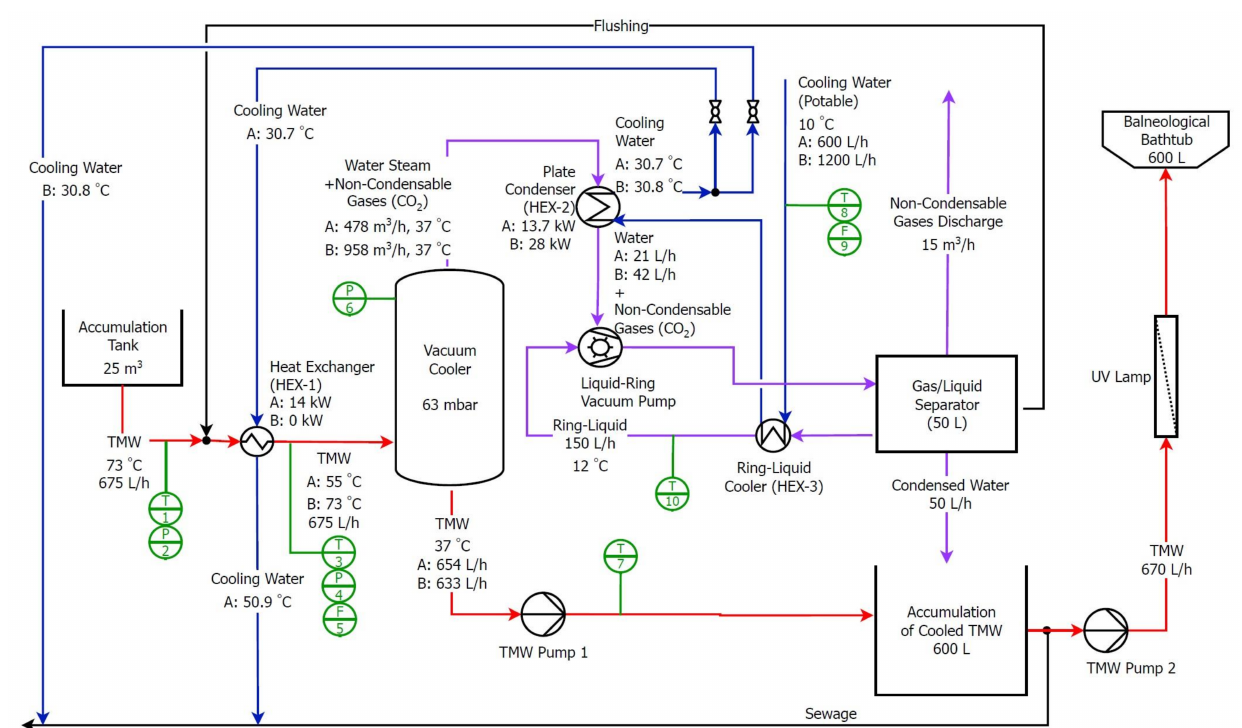
Figure 3. Water consumption and hotel occupancy in 2019.